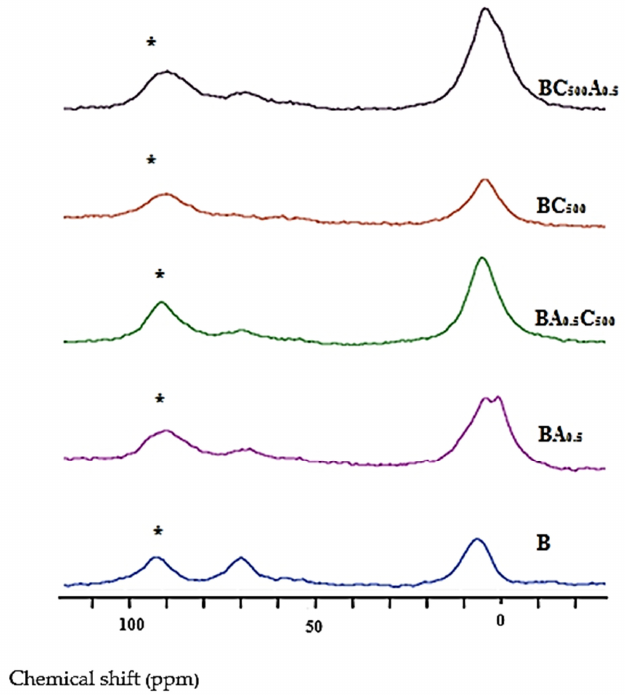
Figure 4. NH 3 -TPD profiles for bentonite and modified bentonite.